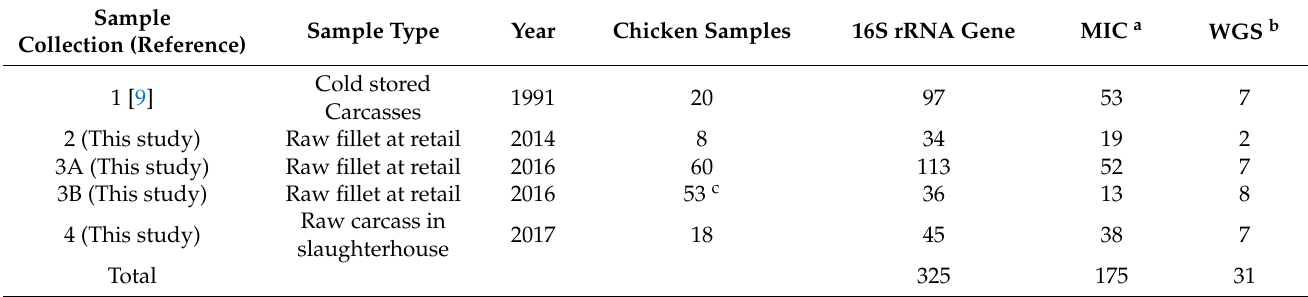
Table 1. Overview of chicken product samples and number of analyzed Pseudomonas